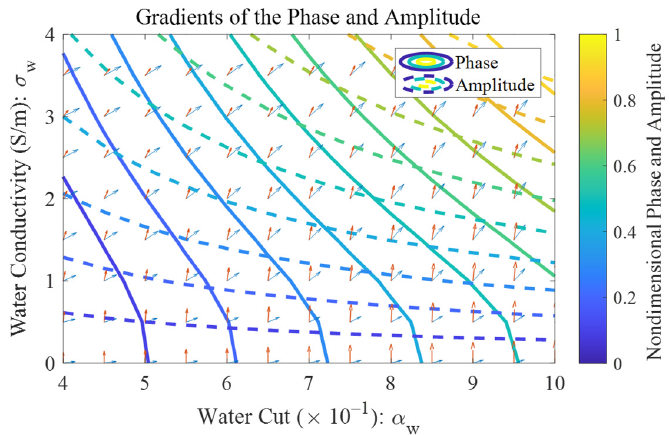
Figure 10. The contour and gradient maps of the phase shift and amplitude attenuation under water-continuous flow conditions. The blue arrows denote the gradient of the phase shift, whereas the red arrow denote the gradient of the amplitude attenuation.